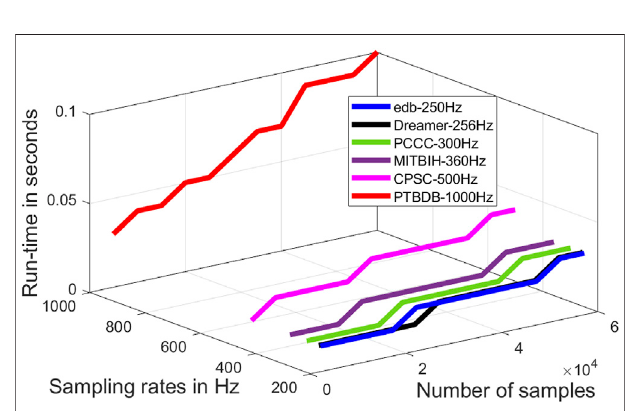
FIGURE 11 | Run-time of the proposed algorithm as a function of the number of samples and sampling rates.